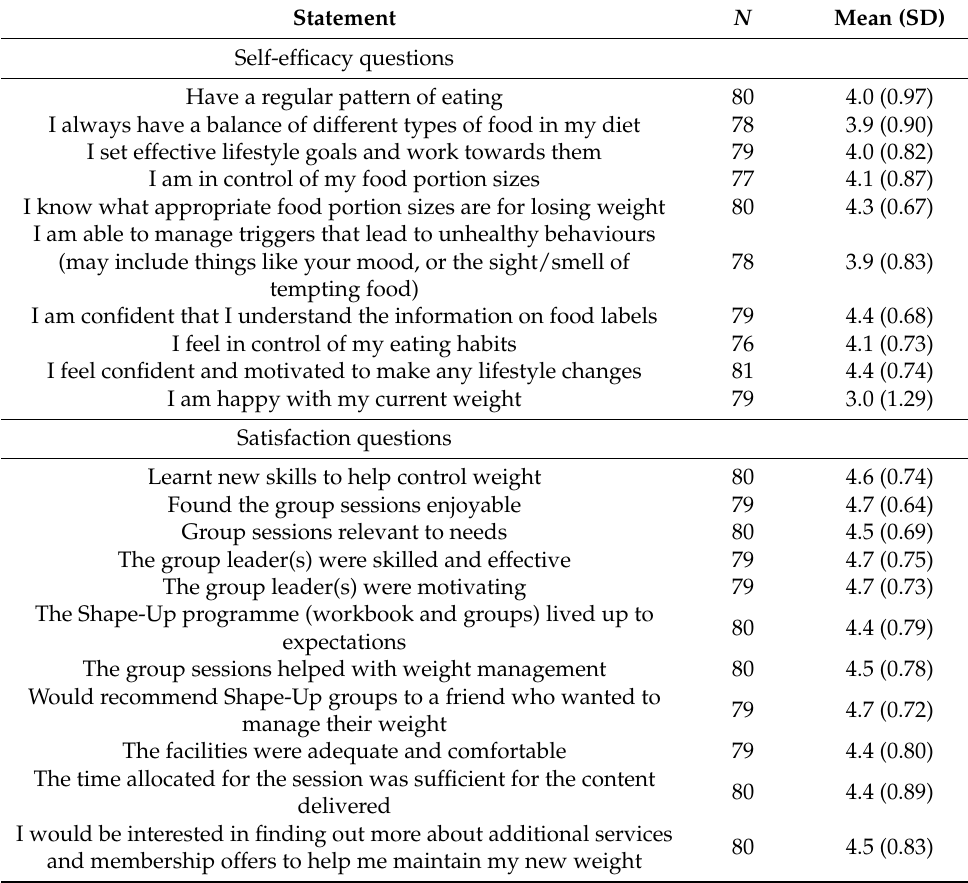
Table 5. Self-Efficacy and Satisfaction Measures at